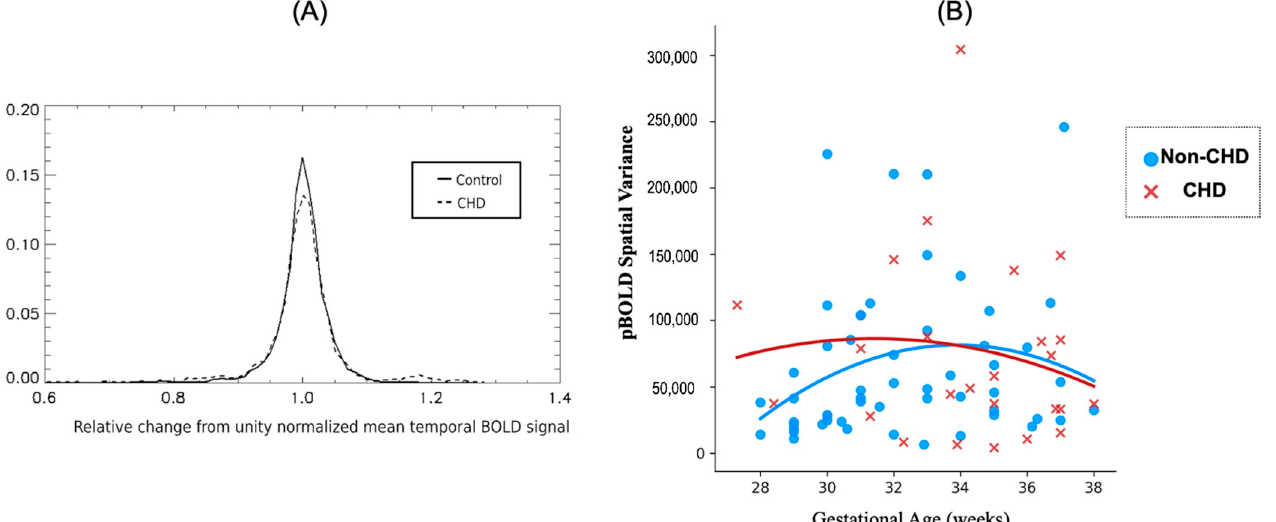
Figure 3. Spatiotemporal characteristics of intrinsic fetal brain BOLD in CHD and non ‐ CHDs: ( A ) Distribution of brain BOLD temporal variance is significantly different between CHD and non ‐ CHD groups, with CHD cases showing a smaller change from unity mean (denoted by red arrow or the width of the base of the curve) indicating reduced temporal variance of the whole fetal brain